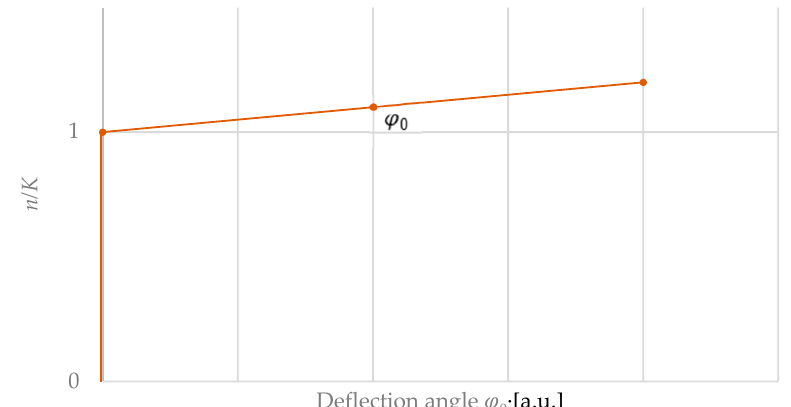
Figure 10. Deflection of a clamped rectangular bending plate as a function of the relative axial force n/K [29].